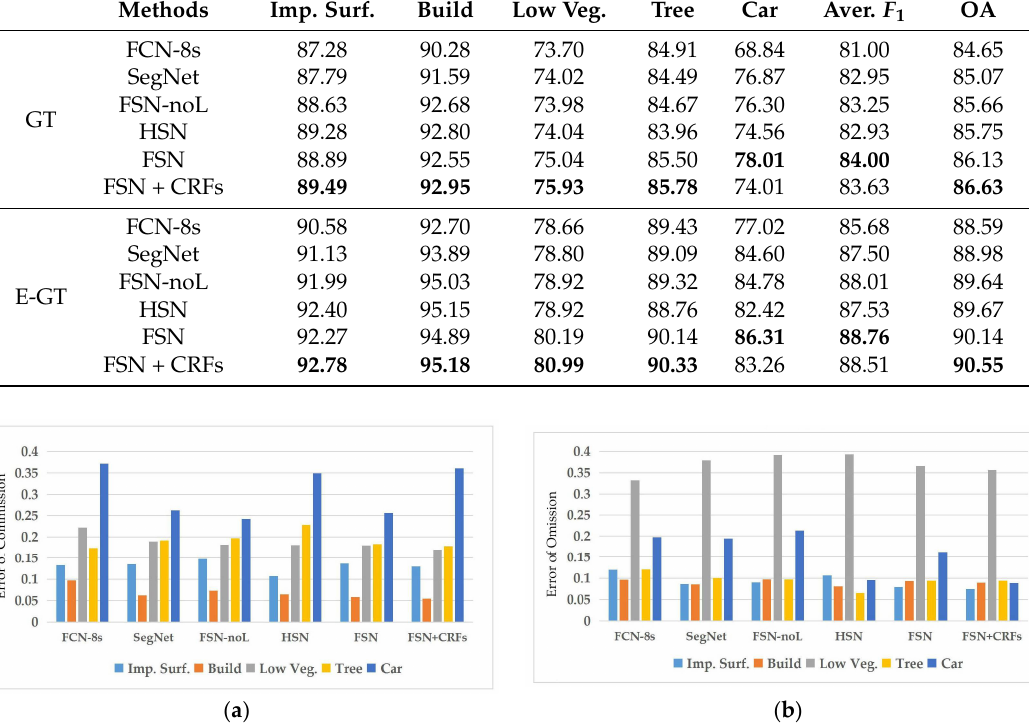
Figure 11. Errors of commission and omission of each model per classes (Vaihingen dataset): ( a ) error of commission; and ( b ) error of omission. Lower values indicate the better segmentation performance. Table 7. Experimental results on Vaihingen test set.